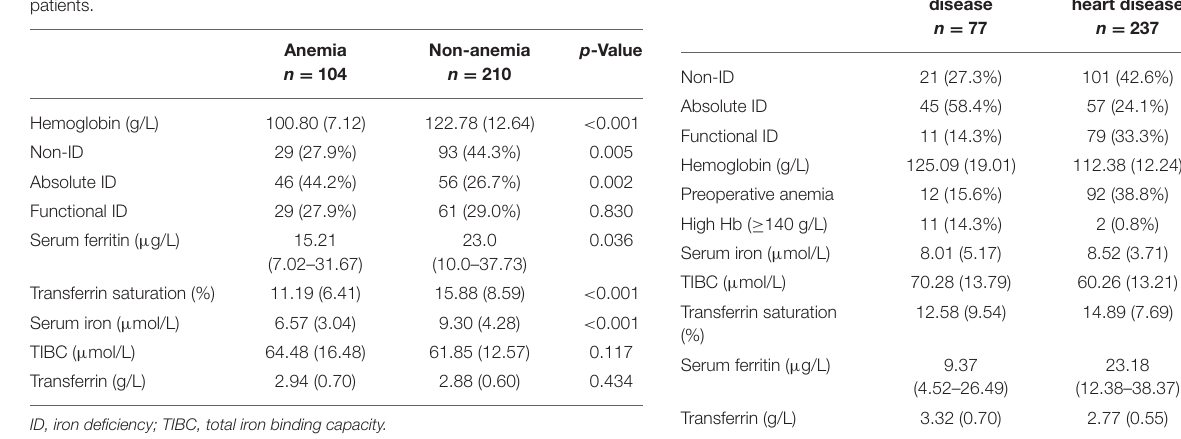
FIGURE 3 | Correlation between serum ferritin and blood urea nitrogen. TABLE 3 | Preoperative status of iron deficiency in anemia and non- anemia patients.